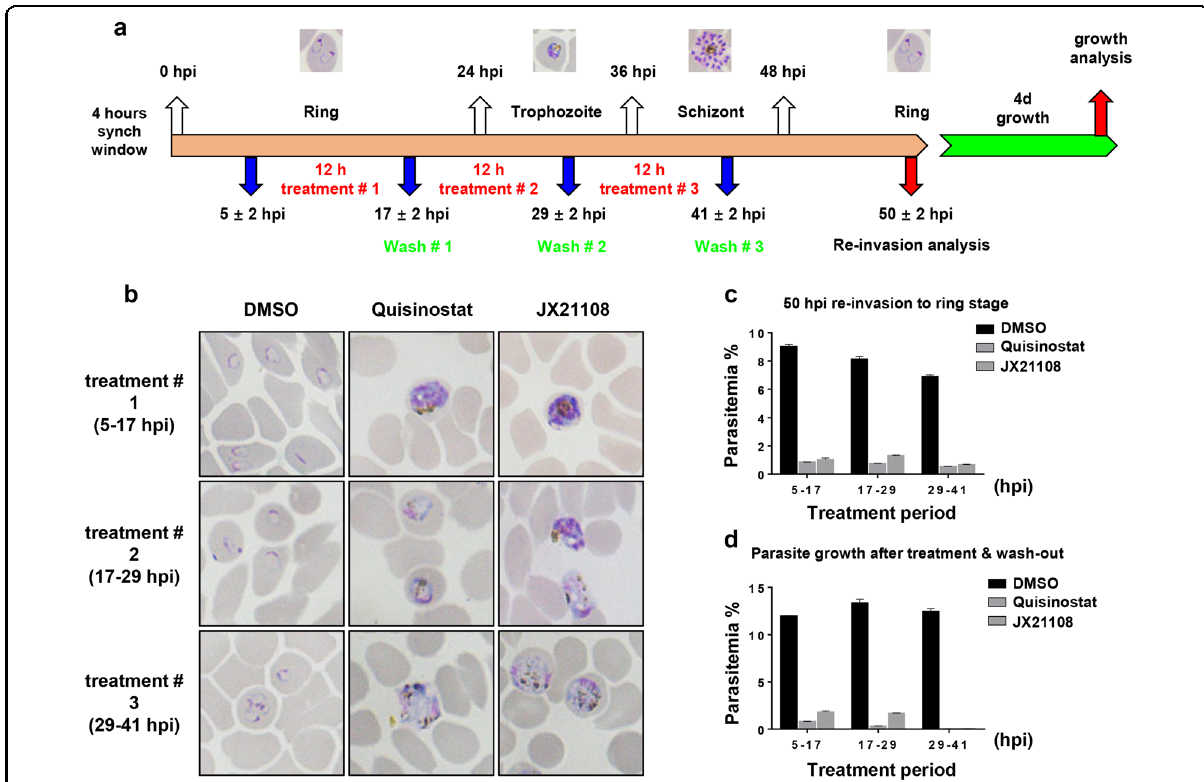
Fig. 3 Stage-dependent antiplasmodial activity of JX21108 in the blood stage. a Schematics of the experimental design. Highly synchronized P. falciparum 3D7 parasites were treated for 12 h with 40 nM of the test compounds or DMSO as a control for three consecutive periods of the intraerythrocytic life cycle. b The morphology of parasites was evaluated by Giemsa-staining smear. c Parasitemia of reinvasion at 50 hpi was measured by fl ow cytometry. d Parasites were washed, followed by 1:40 dilution, and cultured for 4 days while parasitemia was measured by fl ow cytometry. Data in c and d are means ± SEM of 100,000 RBCs from three biological